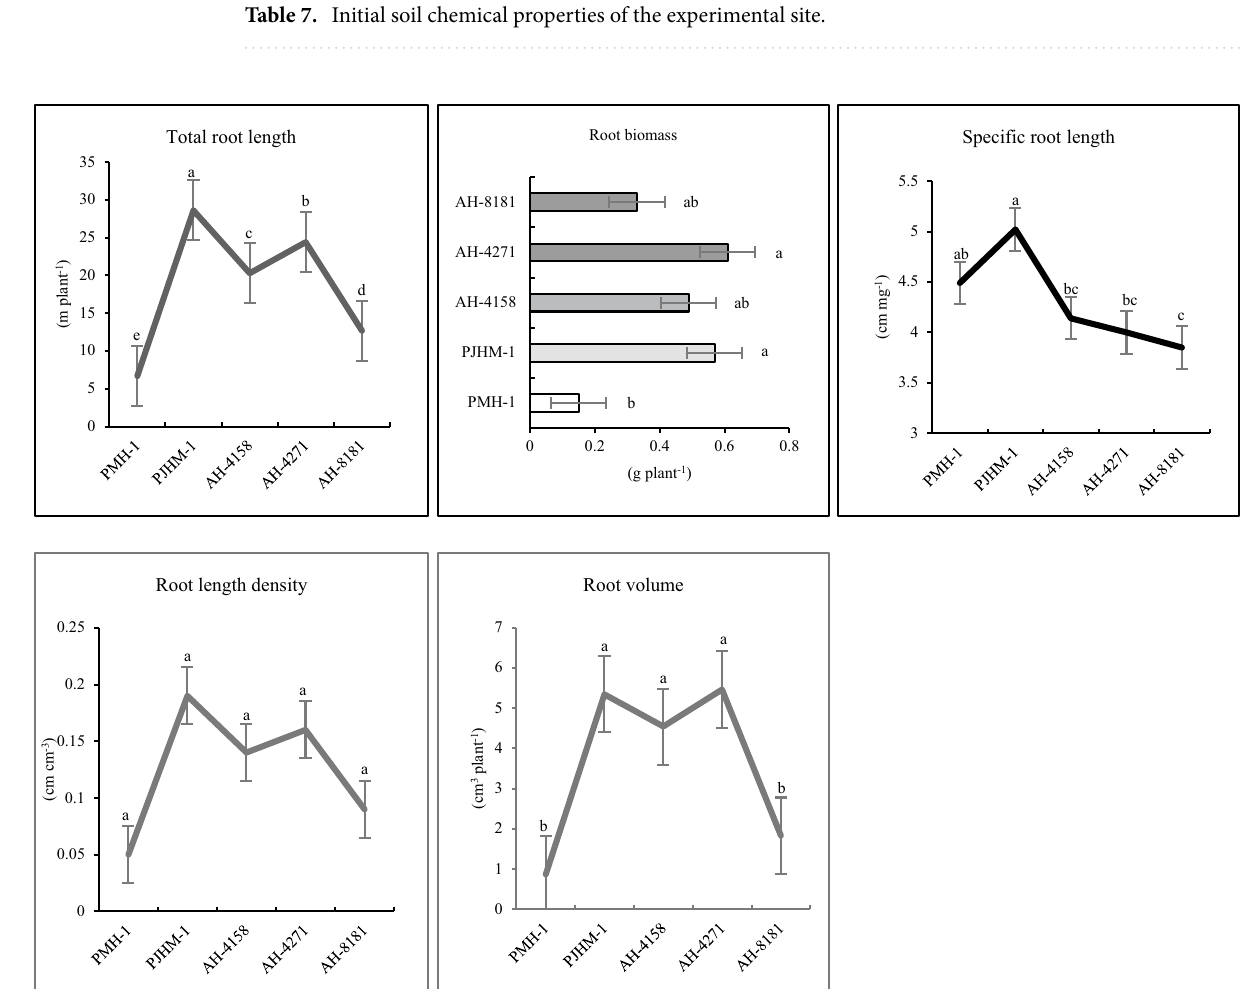
Figure 7. Root morphological traits of five maize hybrids grown in PVC tubes under field condition at V 5 stage (20 DAS). Means followed by different letters on the individual bars/lines of a figure indicate significant difference ( p ≤ 0.05).